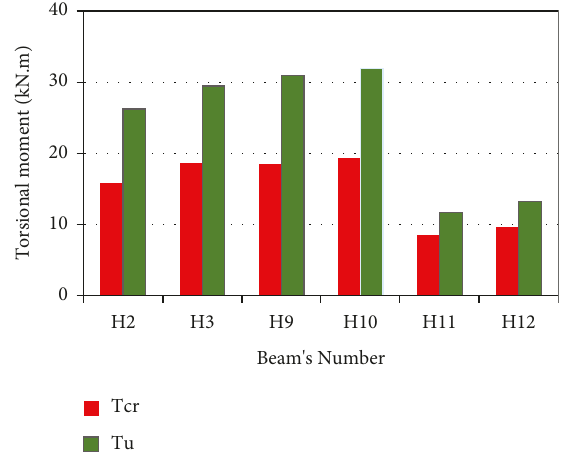
Figure 7: Torsional moment of the tested beams.